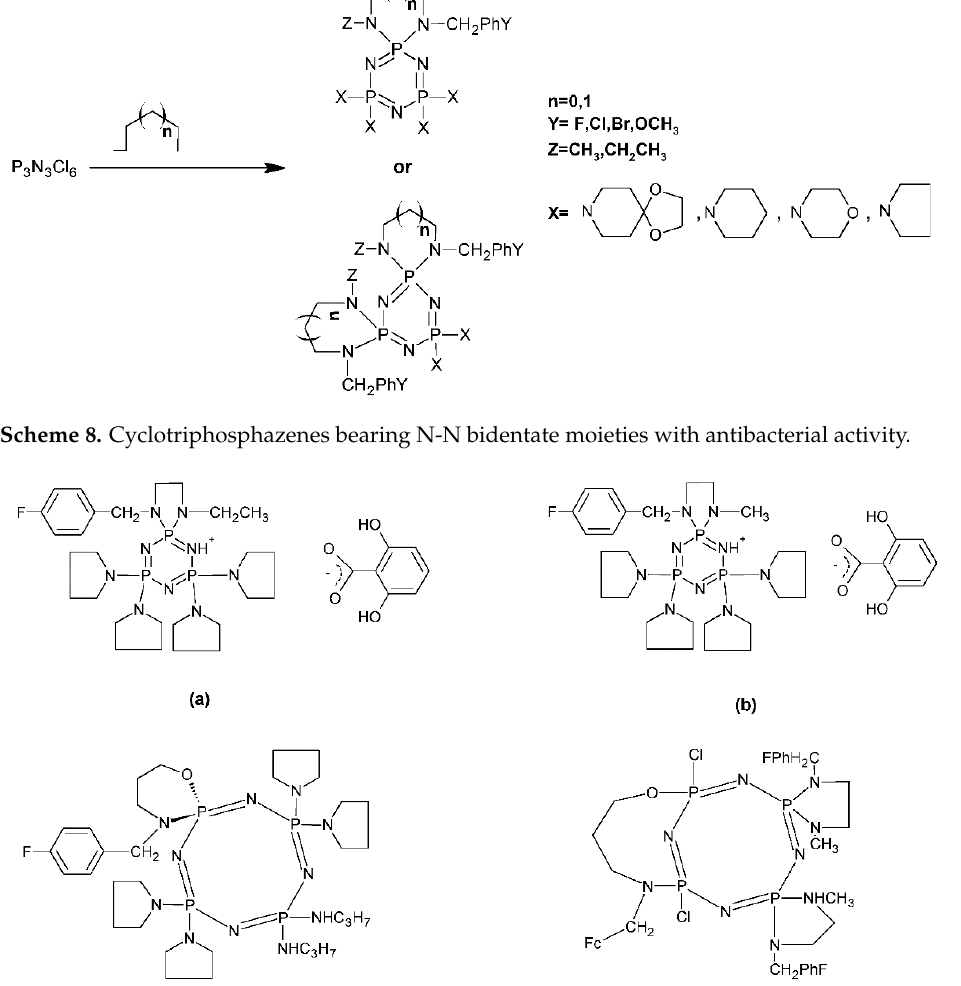
Molecules 2022 , 27 , x FOR PEER REVIEW